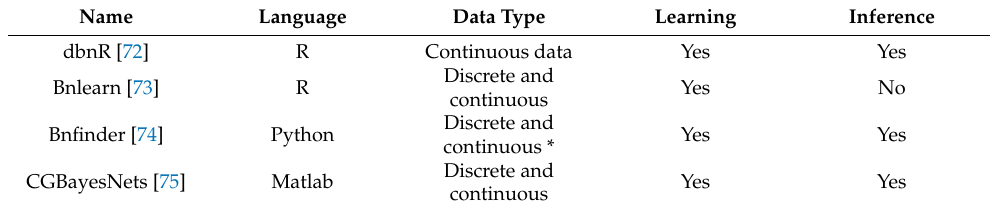
Table 5. Software packages benchmarking (* only if one discrete parent and no